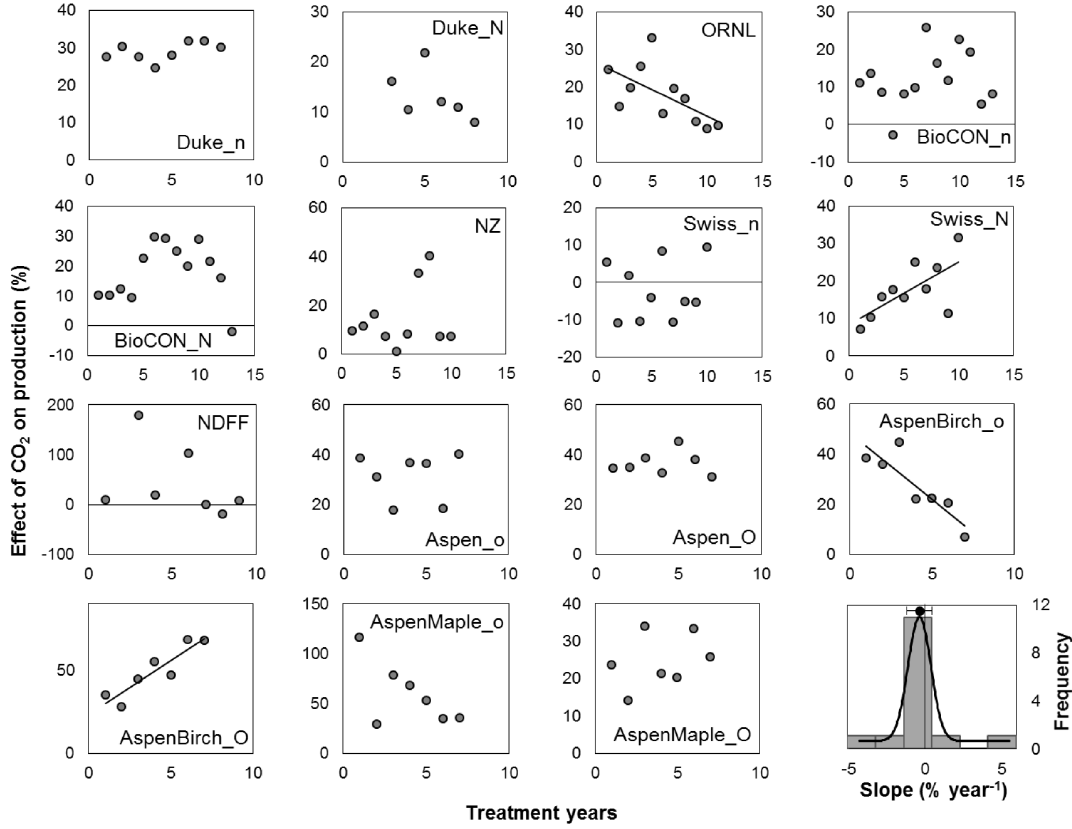
Figure 4. Time courses of CO 2 effects on ecosystem NPP (or biomass or leaf production) in decadal-long FACE experiments. Please see Table 1 for details of experiments, references and statistical results. Only statistically significant ( P <0.05) regression lines are shown. The panel at the right-low corner shows the distribution of the slopes ( − 0.37%year − 1 with 95% CI from − 1.84 to 1.09%year − 1 )